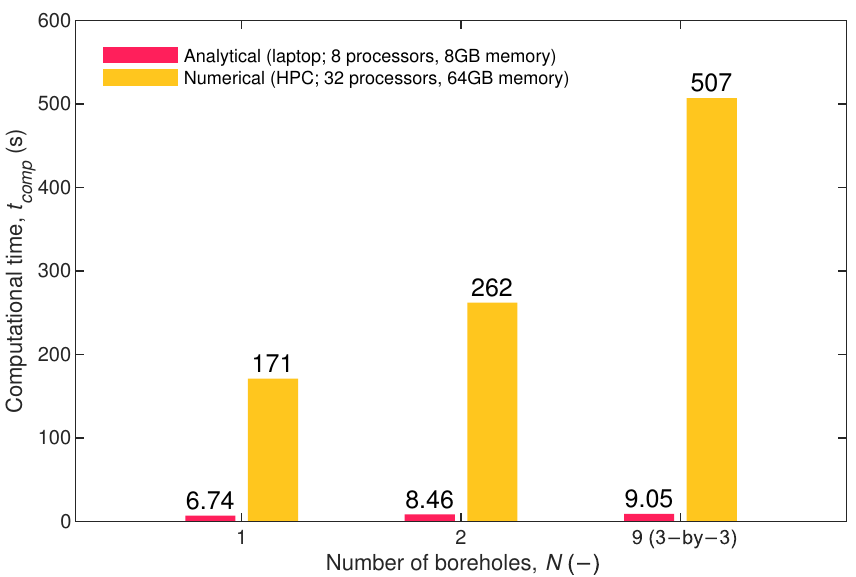
Figure 8. Comparison of computation between the analytical and numerical